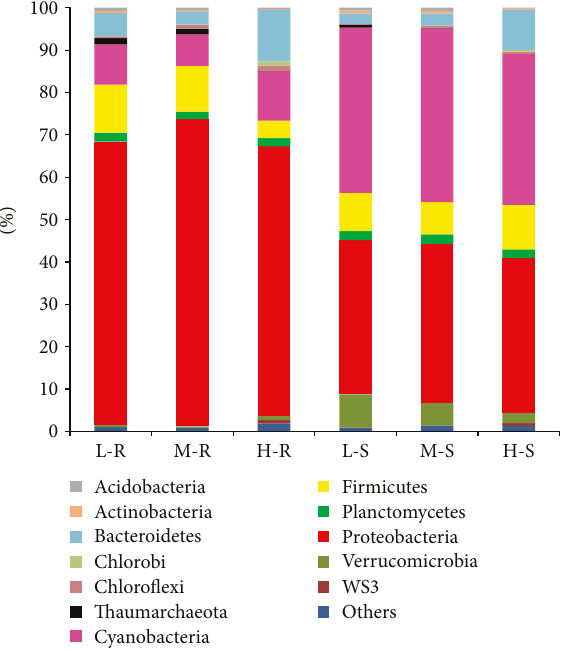
Figure 3: Relative abundance of microorganisms at the phylum level. “ Others ” refers to the sum of rare taxa each < 0.5% of the